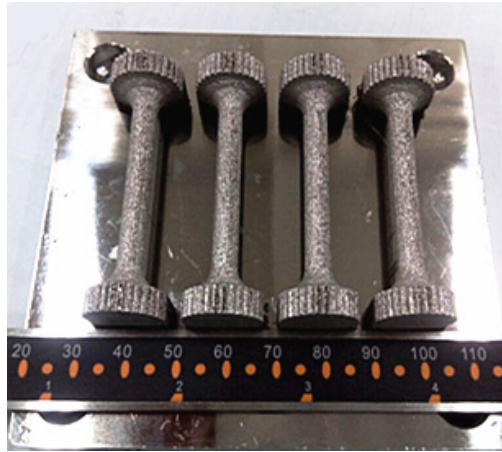
Figure 10. Tensile test sample manufactured by SLM.